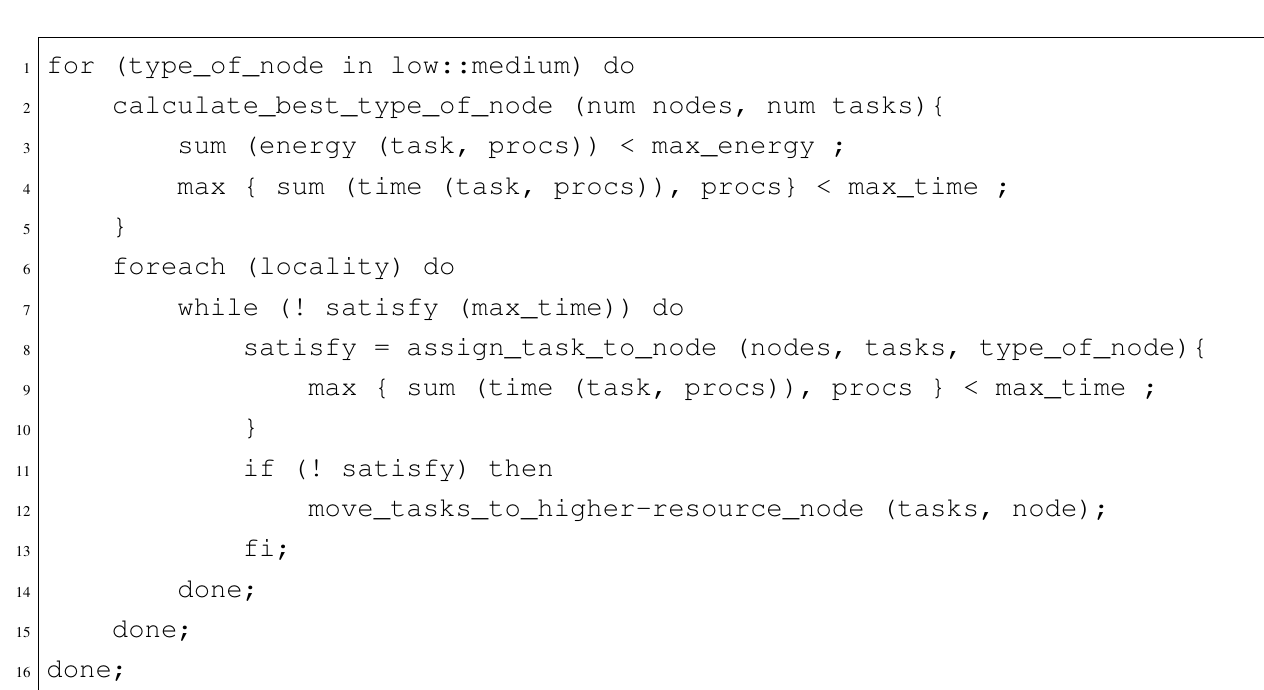
Figure 6. SMT Solver Algorithm pseudocode.